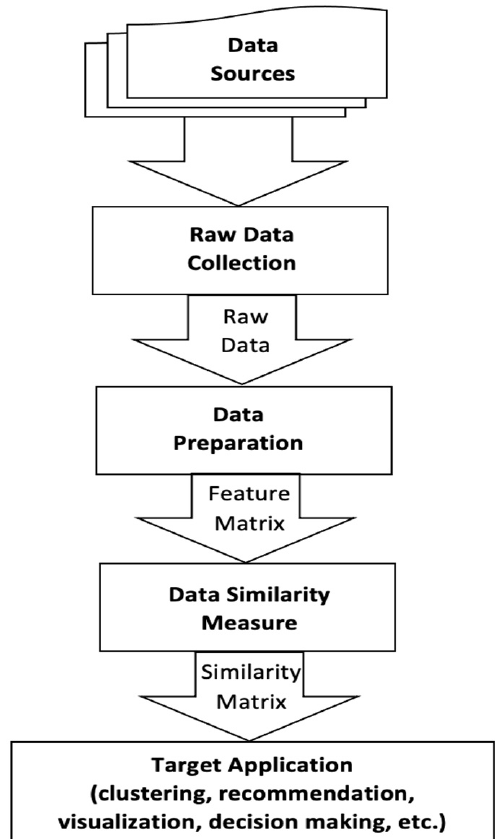
Figure 2. Methodology of computing data